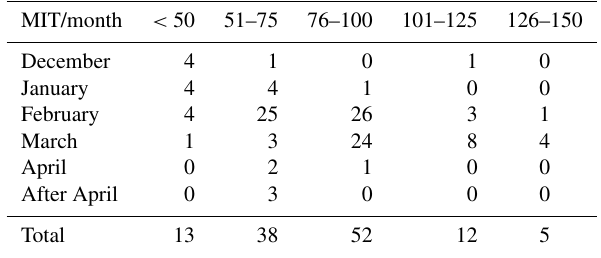
Table 2. The frequency of yearly maximum ice thickness from November to April. The first column represents different months in the cold season, and the other columns represent yearly maximum ice thickness (MIT) with the unit in centimeters.